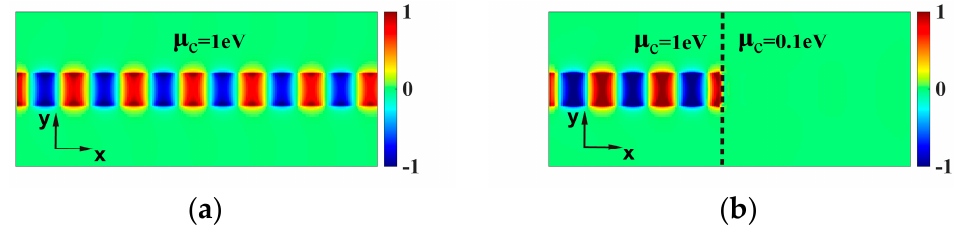
Figure 4. The real part of Ez for ( a ) µ c = 1 Ev and ( b ) µ c = 0.1 Ev. The dashed line indicates the position where the chemical potential of the graphene layer changes from 1 Ev to 0.1